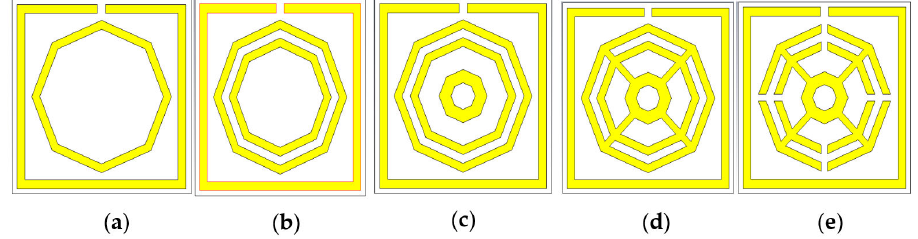
Figure 2. Design optimization views: ( a ) Design-1; ( b ) Design-2; ( c ) Design-3; ( d ) Design-4; ( e ) final design. Table 2. Response of transmission coefficient (S 21 ) for designs steps.